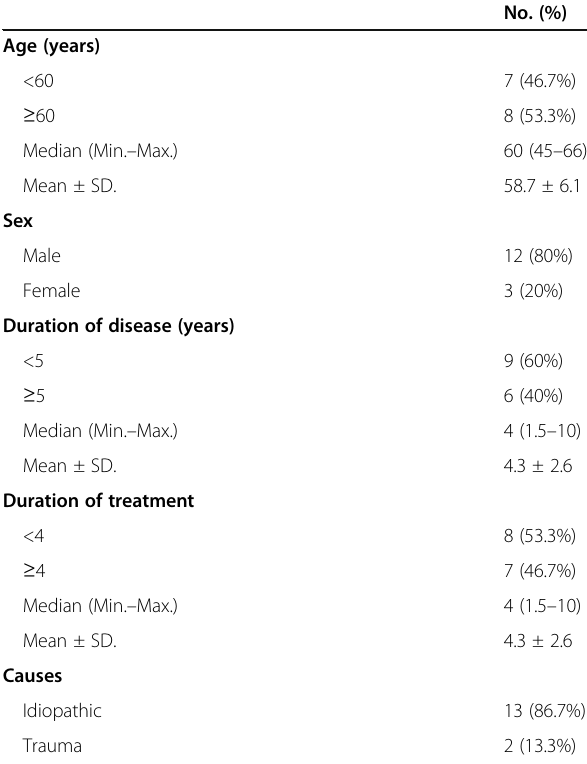
according to age, gender, duration of disease, duration of treatment, and etiology of the